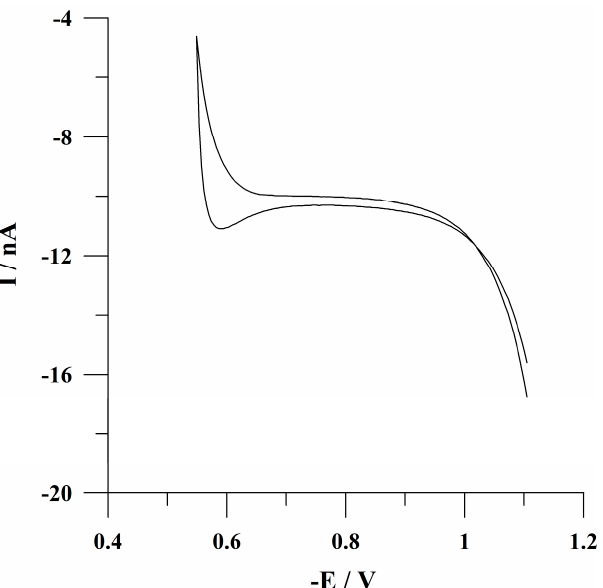
Figure 2. Cyclic voltammogram recorded using a solid lead–tin microelectrode from a solution containing 0.1 mol L − 1 acetate buffer (pH 4.0). Start potential, − 1.1 V; first vertex potential, − 0.55 V; second vertex potential, − 1.1 V. Scan rate 50 mV s − 1